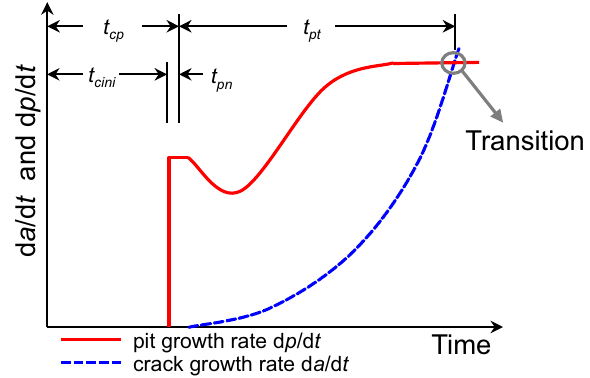
Fig. 2 Rate completion criterion for estimating the pit-to- crack transition